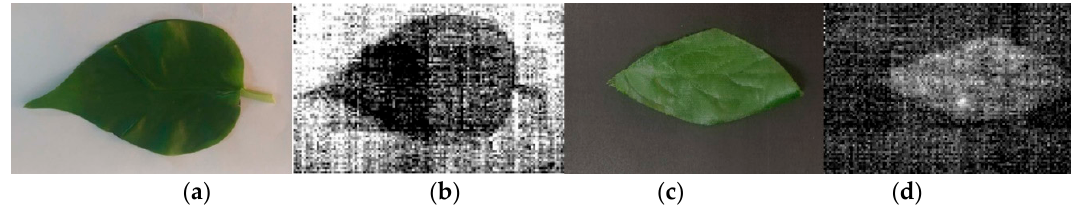
Figure 15. ( a ) Real leaf and ( c ) fake leaf. ( b , d ) Images acquired by the imaging spectrometer at 1935 nm. The real leaf is dark and the fake leaf is bright.